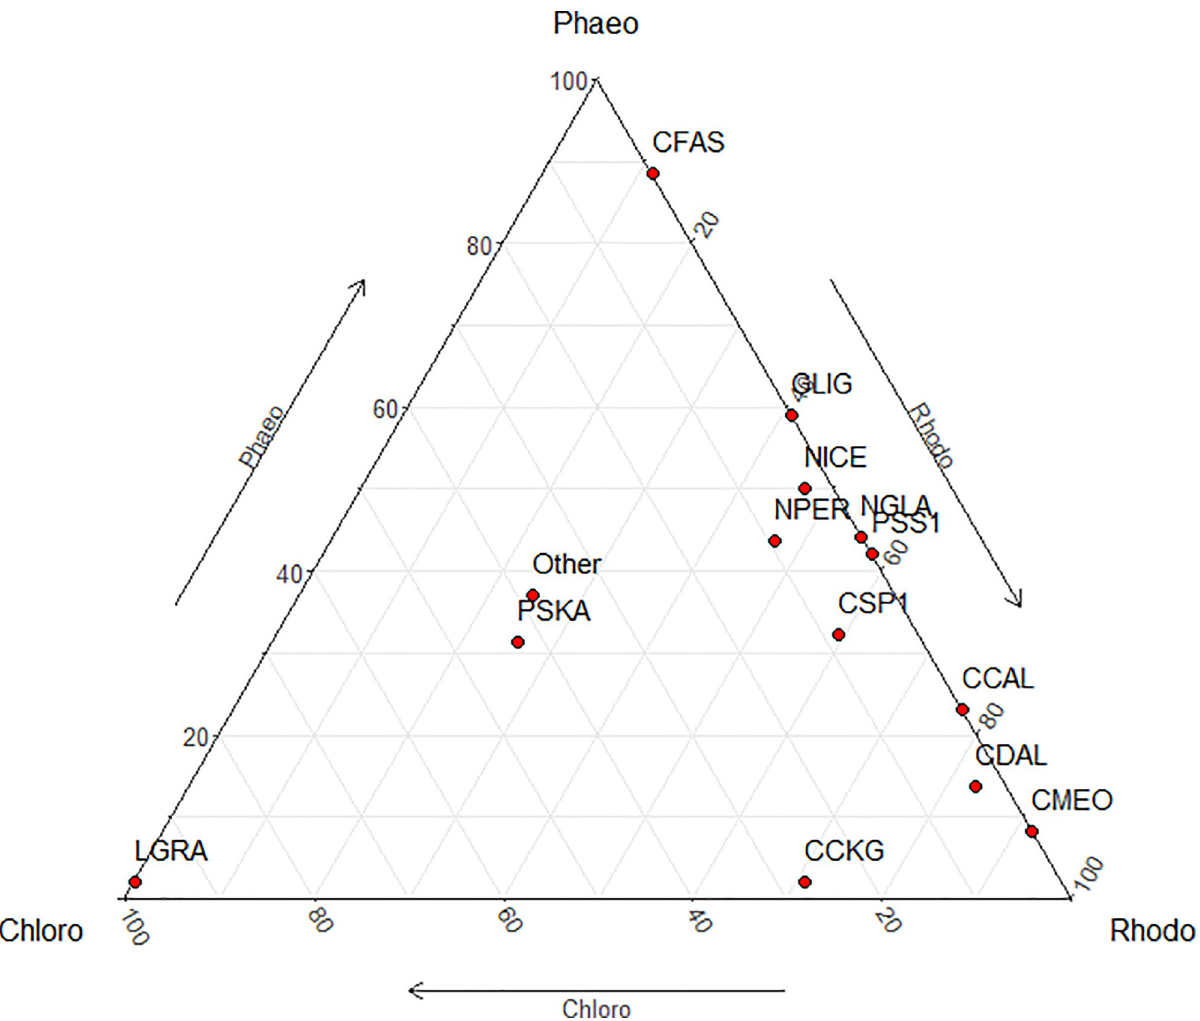
Fig 3. Ternary plot of predominant epiphytic diatoms shared between Rhodophyta (Rhodo), Phaeophyceaes (Phaeo) and Chlorophyta (Chloro). Species codes: CCAL = Cocconeis californica , CCKG = Cocconeis californica var . kerguelensis , CDAL = Cocconeis dallmanii , CFAS = Cocconeis fasciolata , CMEO = Cocconeis melchioroides , CSP1 = Cocconeis sp . 1 , GLIG = Gomphonemopsis ligowskii , LGRA = Licmophora gracilis , NGLA = Navicula glacialis , NICE = Navicula incertata , NPER = Navicula perminuta , PSKA = Pseudogomphonema kamtschaticum , PSS1 = Pseudogomphonema sp 1 , Other = diatom species in under 2% frequency and abundance.